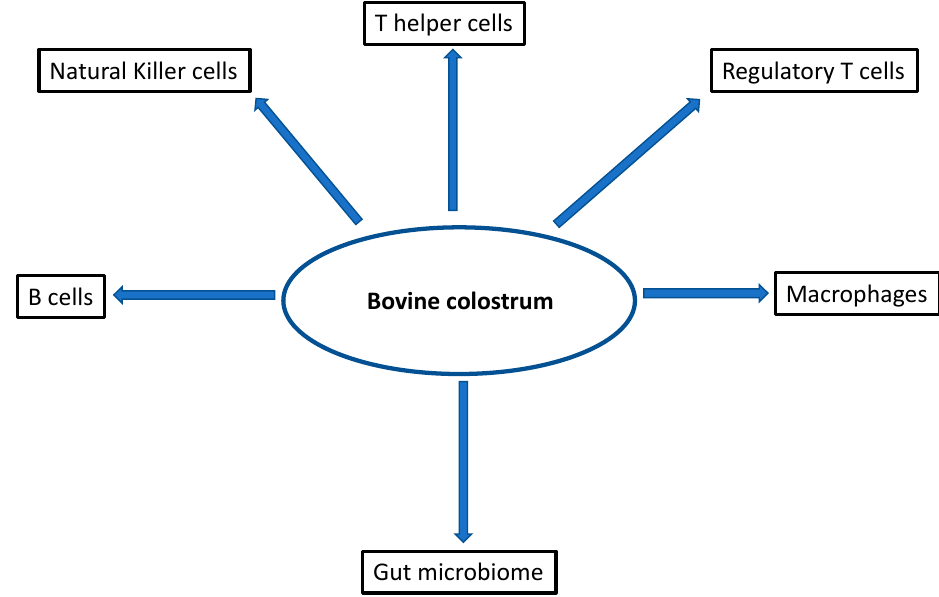
Figure 1. Immune cells that are affected by bovine colostrum.